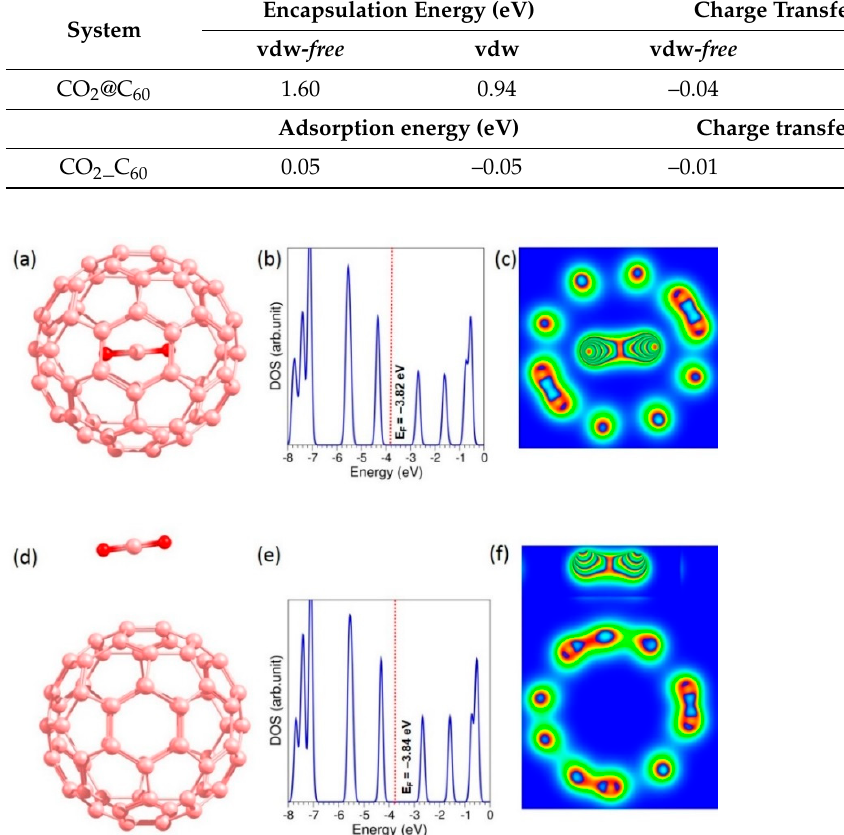
Table 1. Encapsulation and Adsorption energy of a single CO 2 molecule.